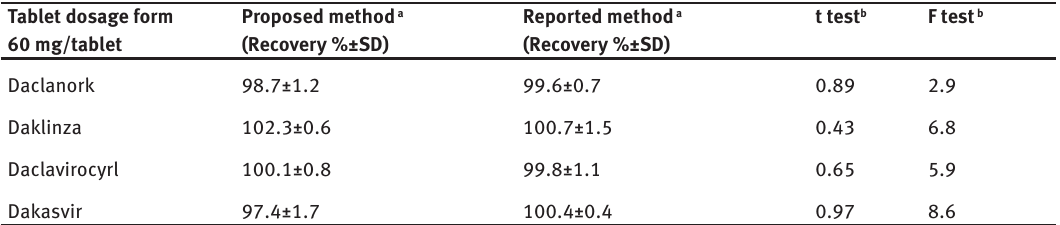
Table 5: Results of quantification of DCV in tablets dosage form.